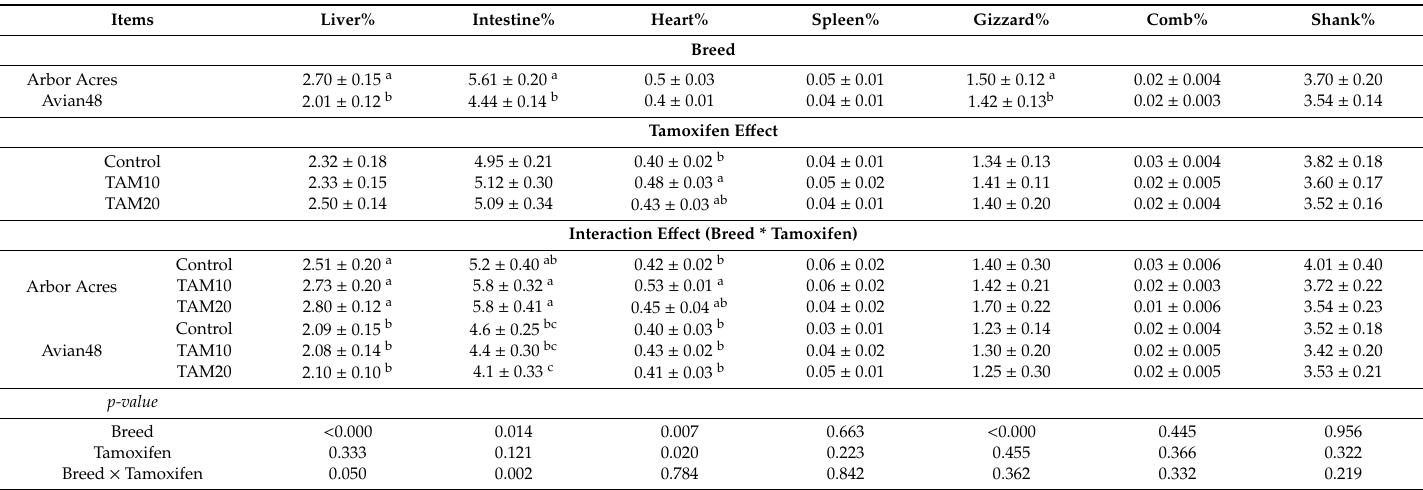
Table 10. The e ff ect of breed, Tamoxifen treatments and their interactions on relative organ percentages based on live weight (Mean ±